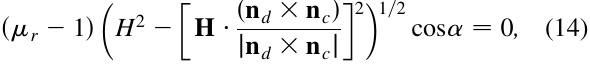
FIG. 22. (Color) Illustration of boundary conditions on the common intersection line of vacuum, dielectric, and perfect conducting wall. On the conducting wall, the electric field only has the normal component while the magnetic field may have two tangent components (not